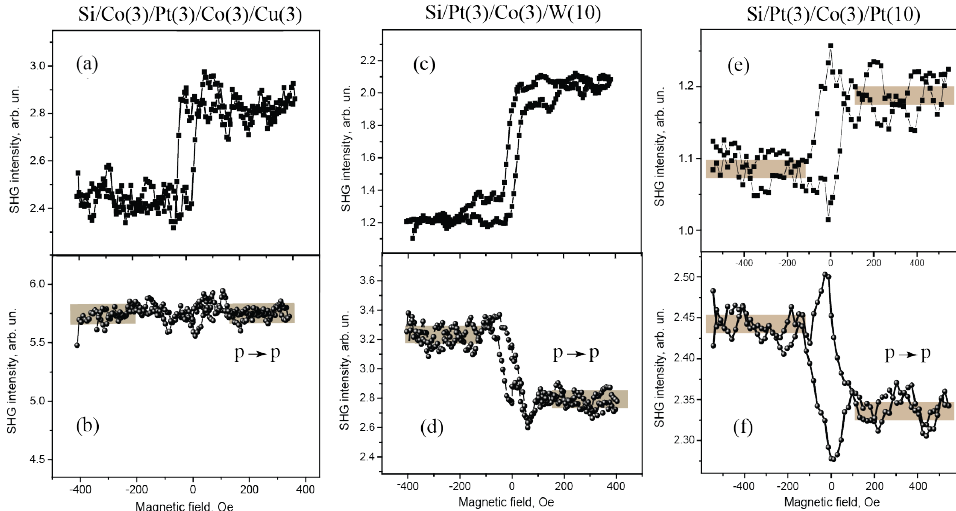
Figure 3. ( a , c , e ) Magnetic hysteresis loops of the SHG intensity measured in the geometry of allowed MOKE-SHG (mixed SHG polarization) for Si/Co(3)/Pt(3)/Co(3)/Cu(3), Si/Pt(3)/Co(3)/W(10), and Si/Pt(3)/Co(3)/Pt(10), respectively; ( b , d , f ) similar dependencies for ”forbidden” MOKE − SHG (as the p − polarized SHG intensity was measured) for the same